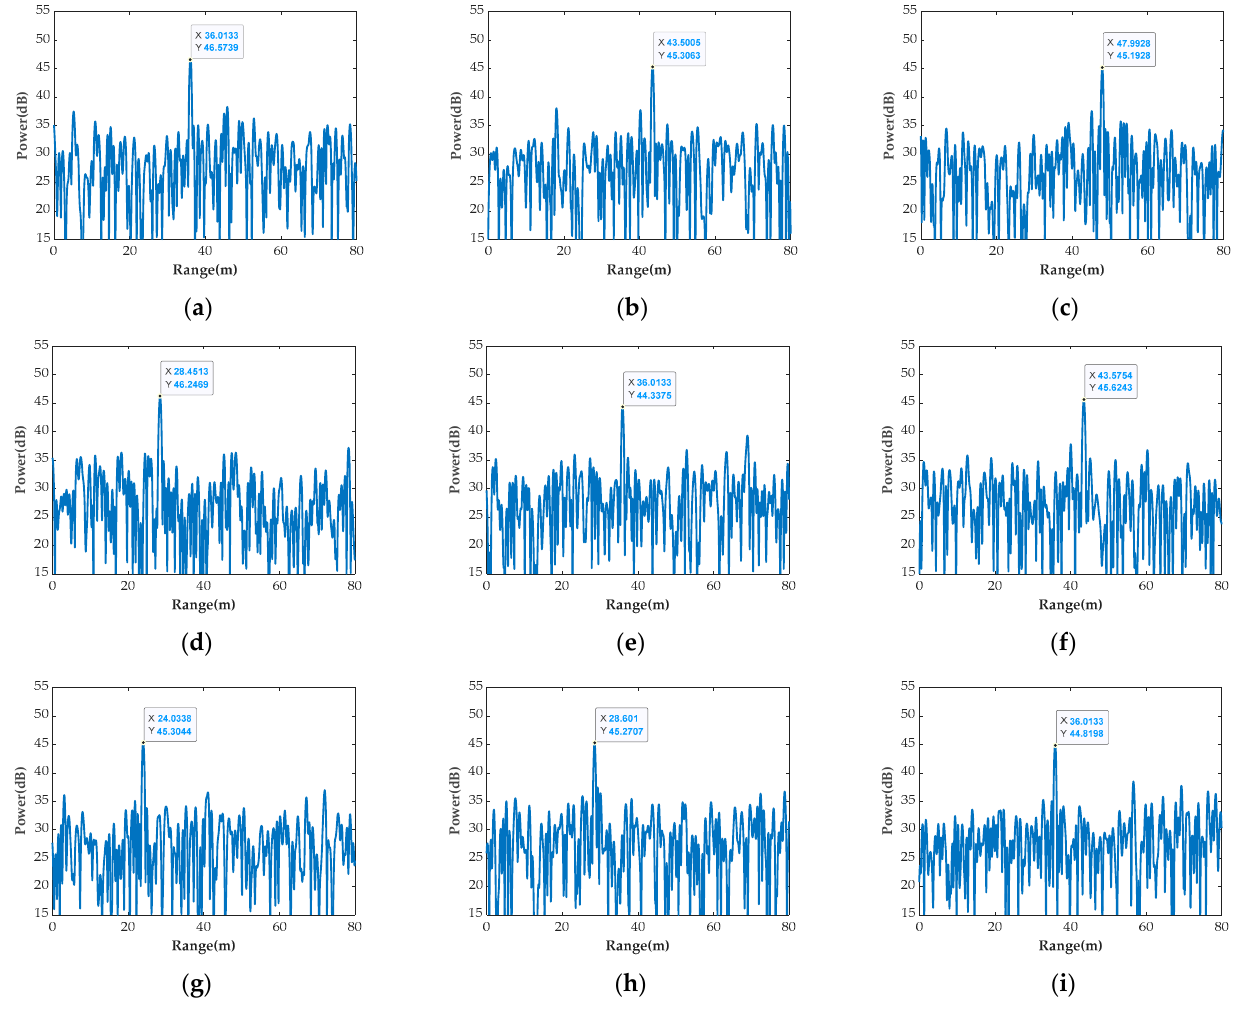
( c ) Figure 12. Multi-target coherent-on-receive synthesis results in consecutive CPIs. ( a ) Results of the dominant scatterer. ( b ) Results of the first weak target. ( c ) Results of the second weak target. Since the multidimensional parameters of the dominant scatterer can be aligned with its own estimated CPs, the synthetic results in Figure 12a are consistent whether adaptive phase compensation is employed or not. However, due to the phase deviation, the syn- thetic performance of weak targets will decline significantly when using the dominant scatterer compensation only, as illustrated in Figure 12b,c. Instead, the synthetic results of weak targets can be effectively improved with the proposed method. Particularly, the maximum gain loss of these targets is 1.9 dB, which satisfies the definition. 4.1.2. Synthetic Results within a Single CPI To demonstrate the synthetic performance, the simulation results of the 10th CPI are presented in Figures 13–15. Due to the synchronization errors, these targets focused on different range cells in multi-channel, as illustrated in Figure 13. The echoes can be cali- brated with the estimated CPs of the dominant scatterer. Figure 14 shows that the devia-